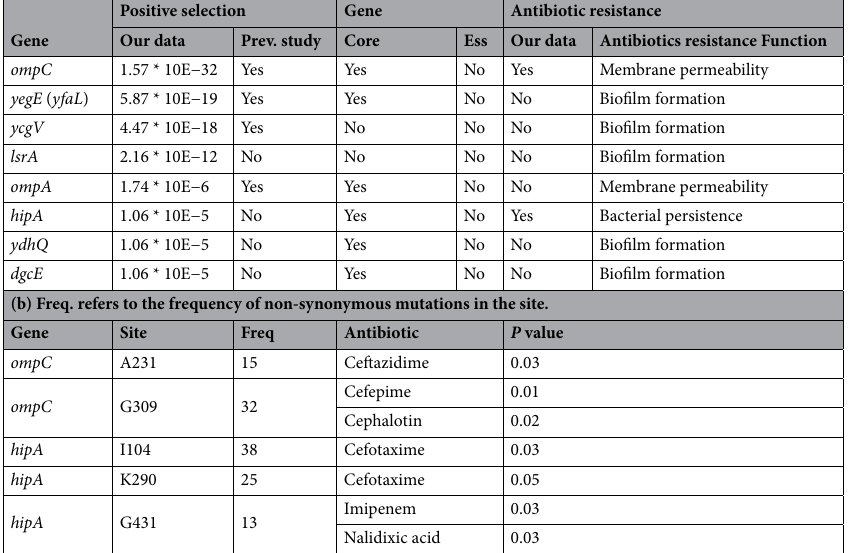
(a) For positive selection, our data give the gene’s p value and prev. study shows whether the gene appeared in other studies. For genes, core indicates whether a gene is a core gene appearing in at least 95% of genomes and ess. indicates essentiality. The column antibiotic resistance lists resistance functions from literature and whether the gene had antibiotic resistance associated mutations in our data (see